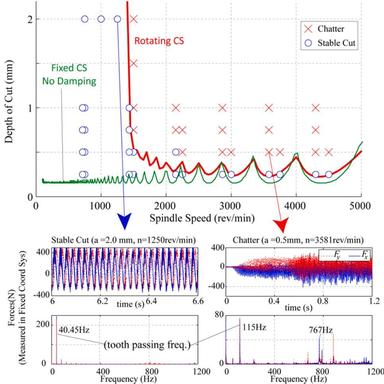
Chatter stability diagram of milling AISI 1045 steel with 2 teeth milling cutter.